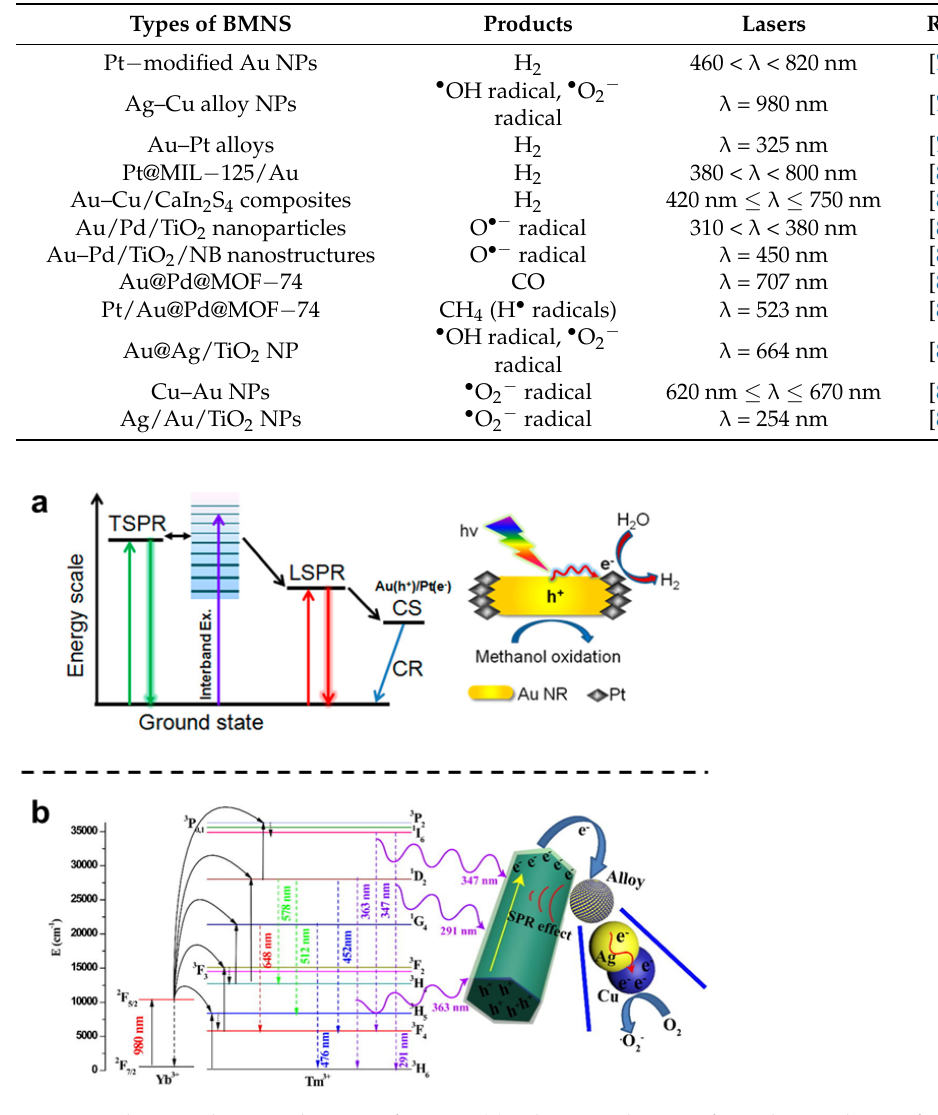
Table 1. BMNs with photocatalytic properties, suitable laser, and products for application.